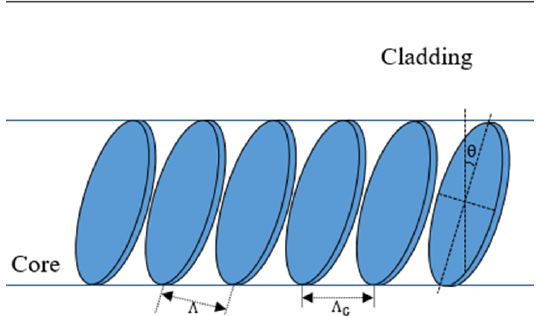
Figure 2. Schematic of a weakly TFBG internal structure.